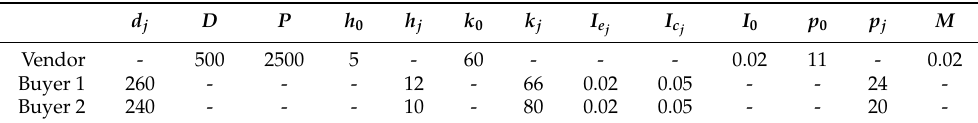
Table 2. Input data for Example